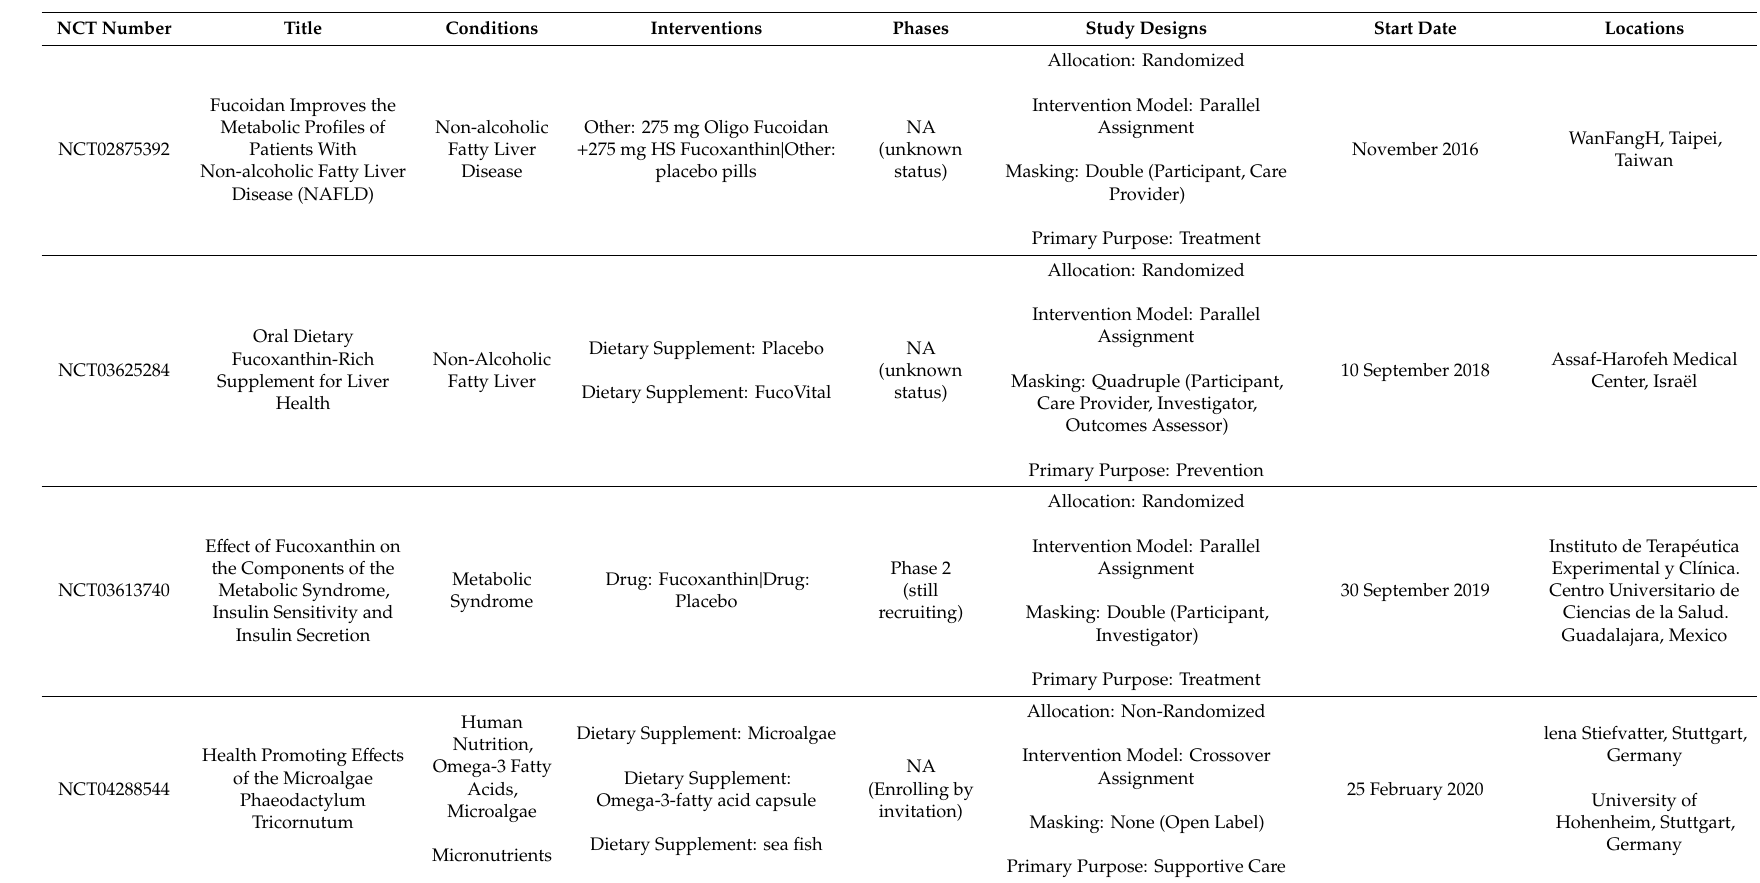
Table 5. Clinical trials involving